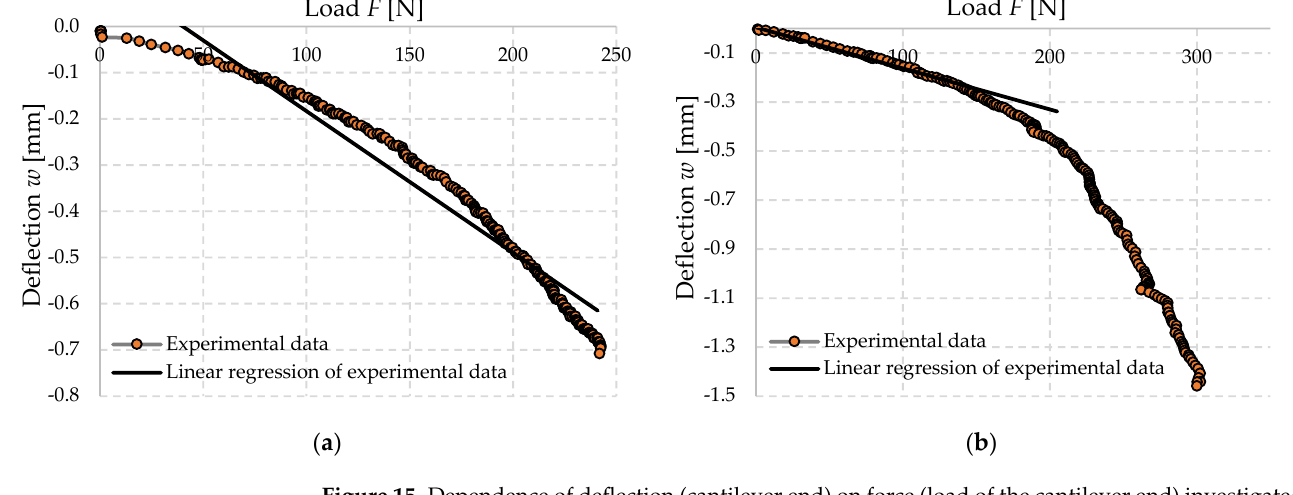
Figure 15. Dependence of deflection (cantilever end) on force (load of the cantilever end) investigated FC500 specimen 35030420, ( a ) not corrected data, ( b ) with used calibration of measuring system. Table 3. Selected material properties of the FC